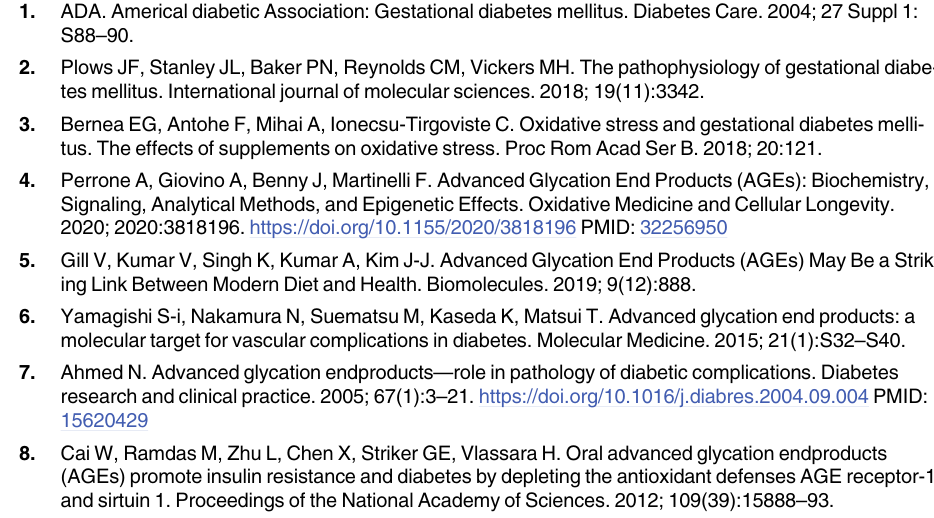
S1 Table. Completed PRISMA checklist. The checklist highlights the important components addressed while conducting systematic review and meta-analysis from observational studies. S2 Table. Data abstraction format with crude data. The table presented the ways of data col- lection (study characteristics and outcome measures) in Microsoft excel format. S3 Table. Critical appraisal scores of included studies. The table shows the risk of bias assess- ments of studies with regard to design, conduct and